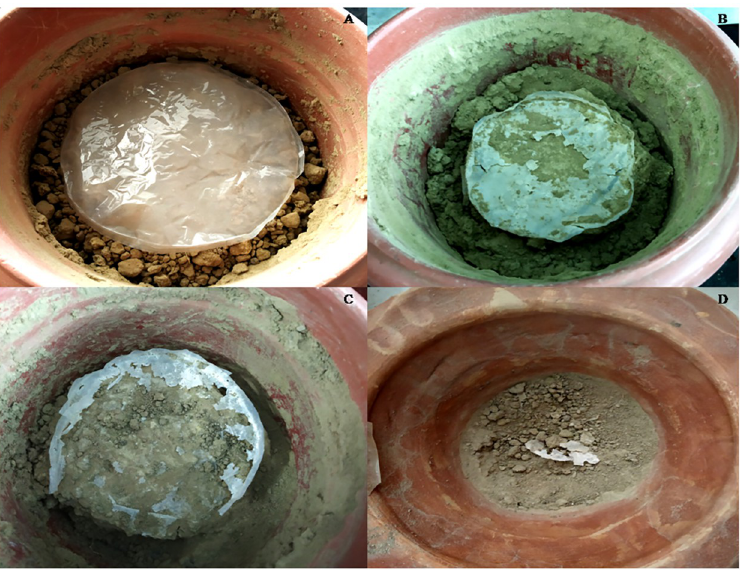
Fig 7. Soil burial method for the degradation of PHB film as compared with (A) control after treatment with the Aeromonas caviae Kuk1-(34) sp. for (B) 15 days (C) 30 days and (D) 45 days.